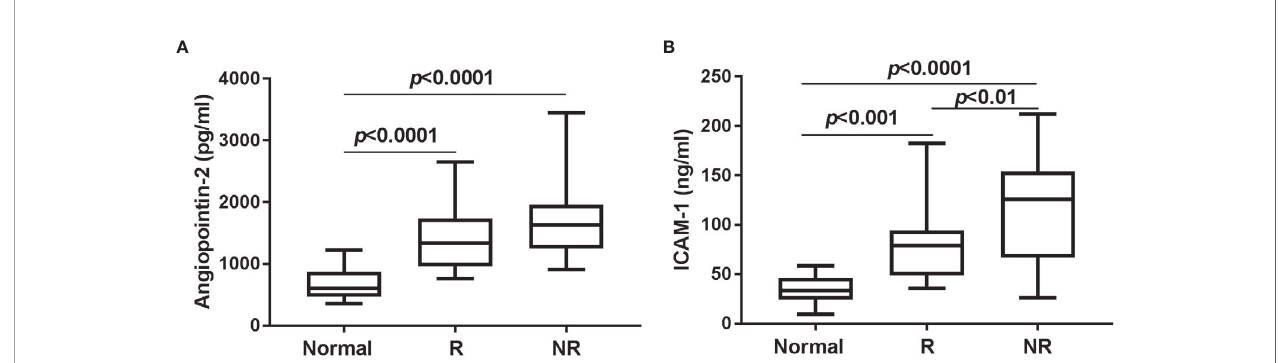
FIGURE 3 | Plasma concentrations of Angiopoietin-2 (A) and ICAM-1 (B) at enrollment in healthy volunteers (Normal) and 29 corticosteroid resistant ITP patients who received consecutive low-dose decitabine therapy, including 15 responders (R) and 14 non-responders (NR).